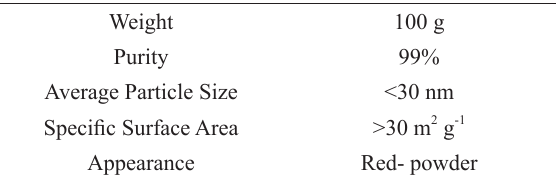
O Nanopowder used in the 2 3